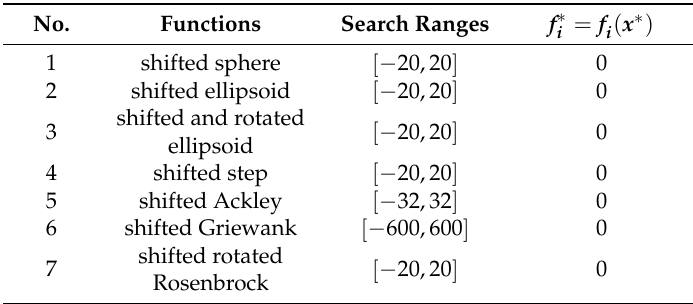
Table 1. Summary of the test